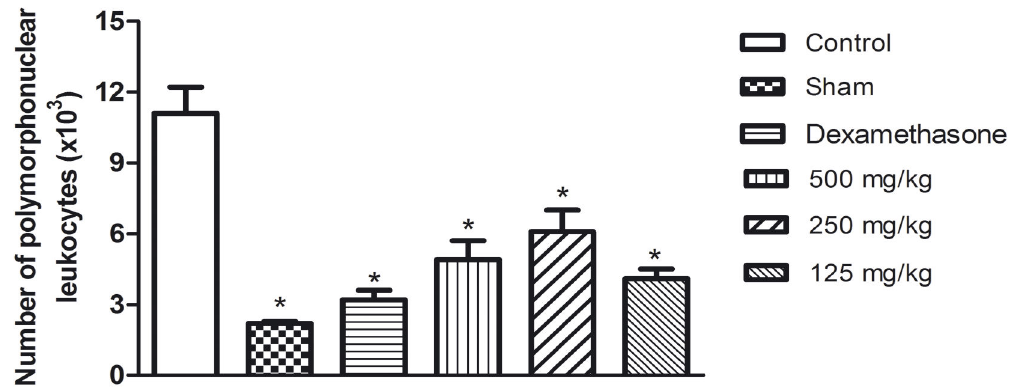
Figure 2. Number of polymorphonuclear leukocytes (x10 3 ) in exudate of the pleural cavity after 4 h of pleurisy induction by carrageenan in mice previously treated with aqueous seed extract. Data are presented as mean ± standard deviation of groups with 6 animals. *p<0.05 in comparison with control by ANOVA followed by Newman-Keuls test. doi: